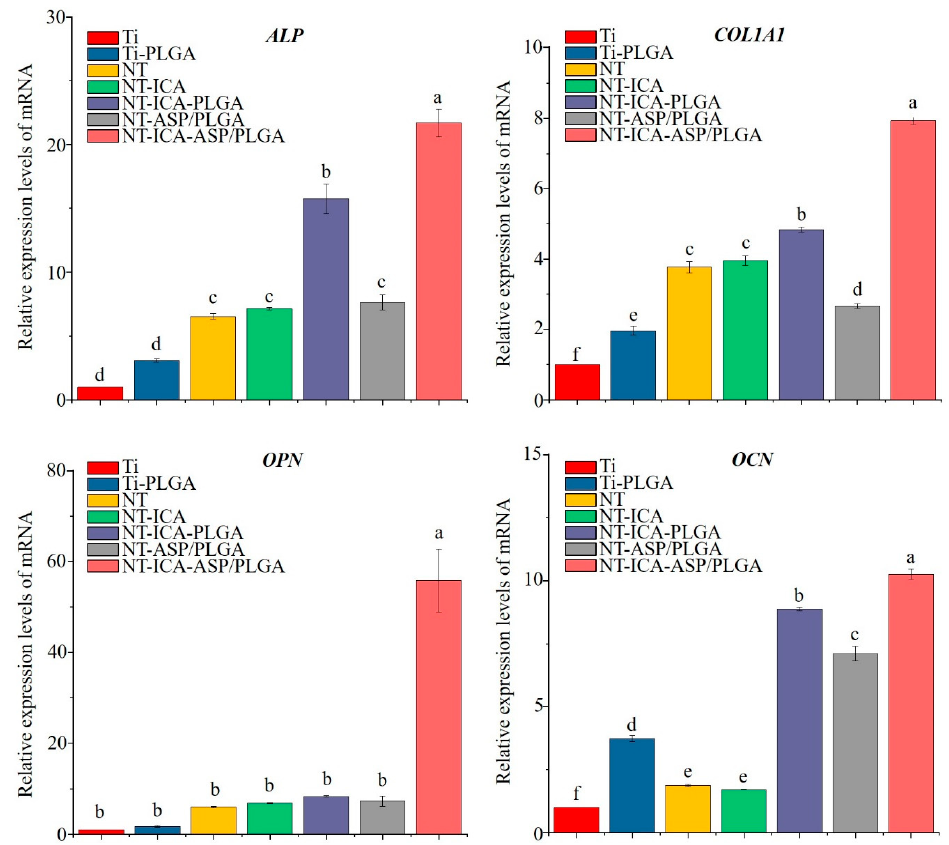
Figure 11. Real-time PCR results representing the gene expression levels of alkaline phosphatase (ALP), collagen type 1 alpha 1 (COL1A1), osteopontin (OPN) and osteocalcin (OCN) in MC3T3-E1 cells after 14 days of culture on different samples. Different lowercase letters indicate statistically significant differences between different groups ( p < 0.05). Data are mean ± SD, n = 3 replicates each group.